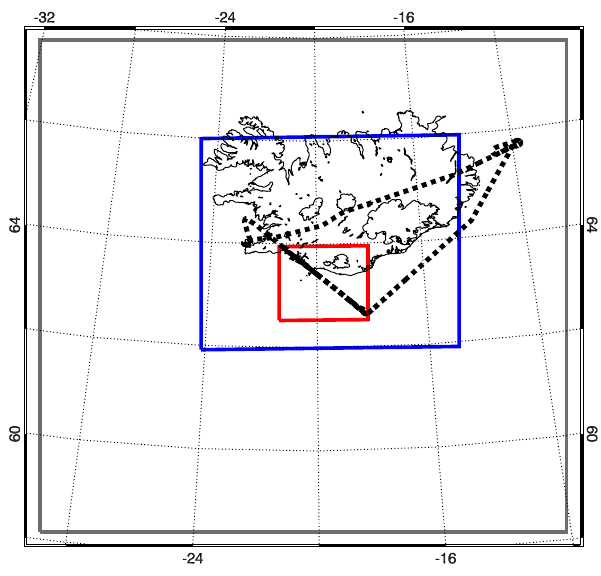
Fig. 5. The WRF/Chem model domains. The grey box shows G1, the blue box G2 and the red box G3. The dotted line corresponds to the aircraft